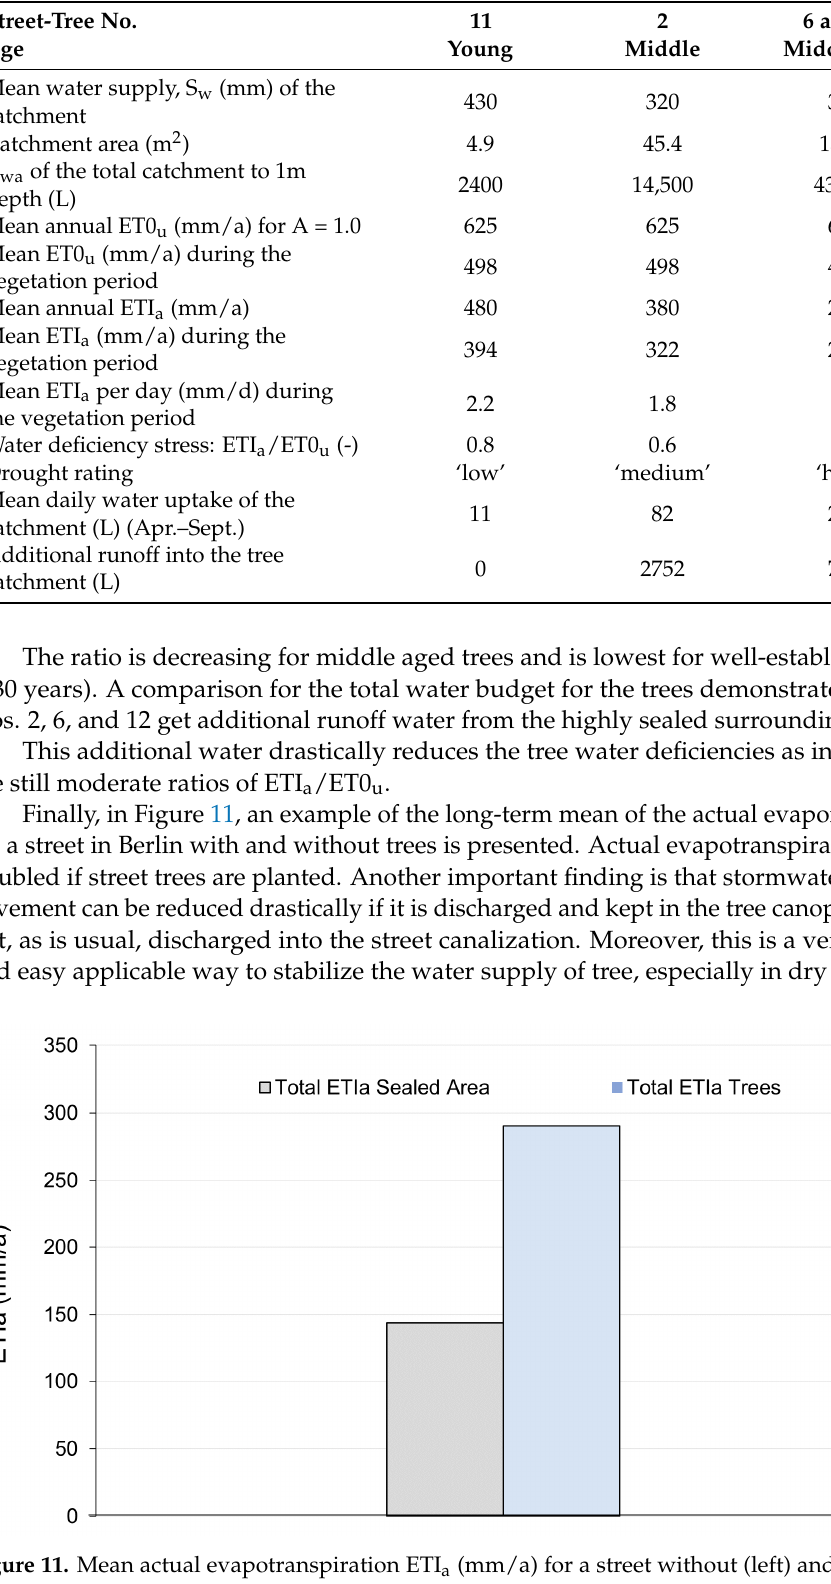
Figure 11. Mean actual evapotranspiration ETI a (mm/a) for a street without (left) and with street trees (right) in Berlin.